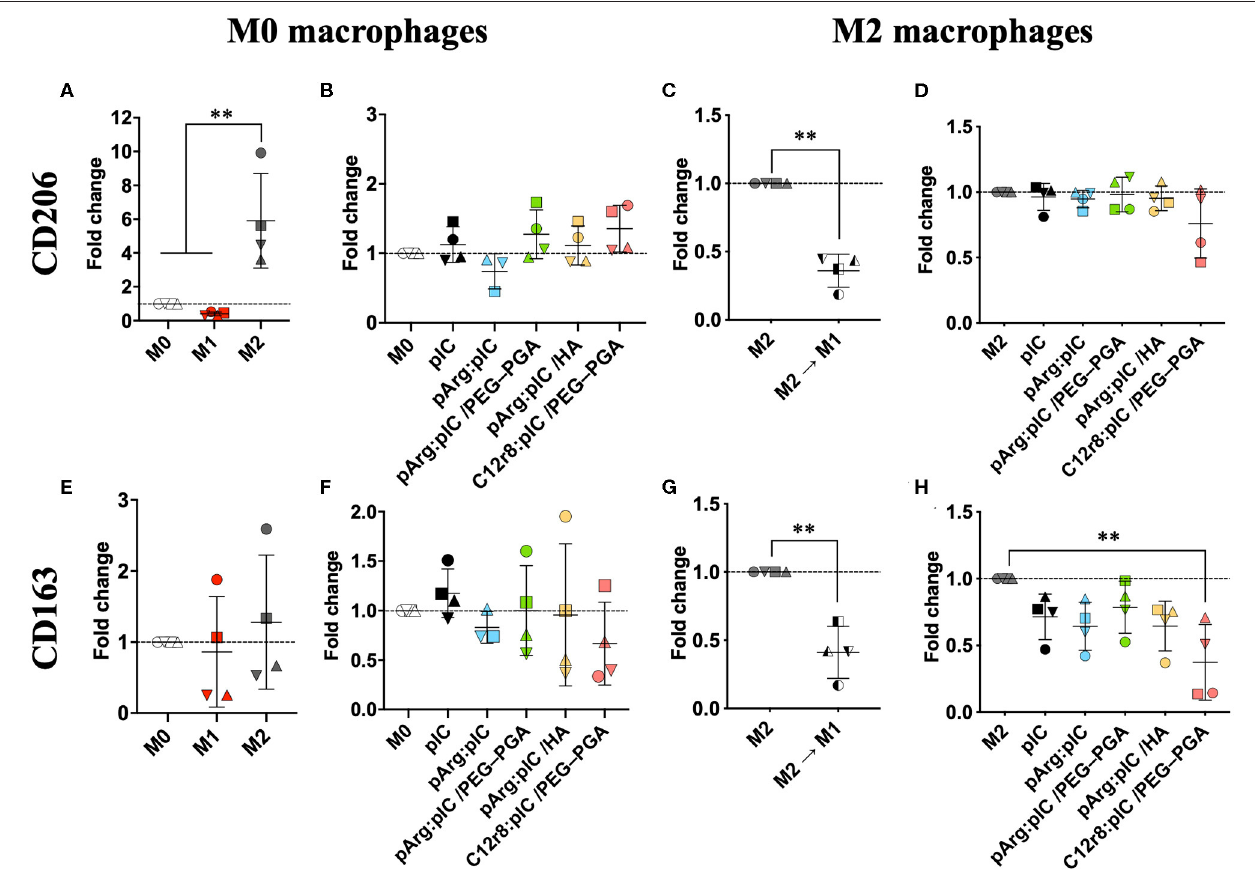
FIGURE 4 | Polarization of M0 and M2 macrophages after treatment with free and nanocomplexed poly(I:C). Expression of the M2 markers (A–D) CD206 and (E–H) CD163 in ENCP-treated M0 and M2 macrophages, in comparison to the prototypic phenotypes evaluated by FACS. M2 M1 represents M2 macrophages that were treated with LPS + IFN- γ for their M1 polarization. Macrophages were incubated with the treatments for 48h, and the poly(I:C) dose used was 5 µ g/mL. Each symbol shape represents a different donor. Values are shown as mean ± SD ( n ≥ 3). Statistical comparison was done using an ordinary one-way ANOVA followed by a Tukey’s comparison test between groups; or a paired t -test for (C,G) . Statistically significant differences are represented as ** p < 0.01. C12r8, laurate-octaarginine; HA, hyaluronic acid; pArg, poly-arginine; PEG–PGA, pegylated polyglutamic acid; pIC,